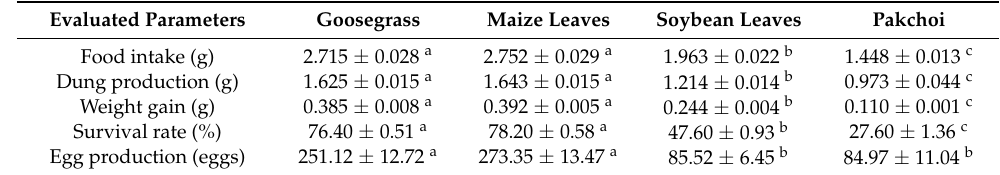
Table 1. Productive parameters of the nymph and Egg production of the female of Locusta migratoria manilensis reared on four food